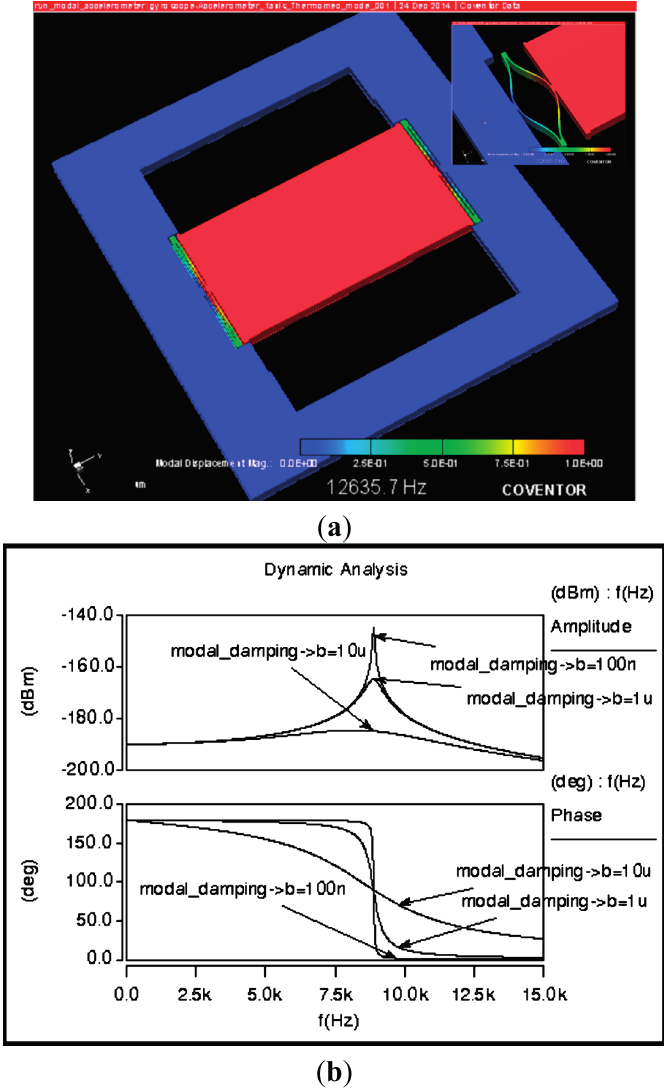
Figure 3. Device modeling results. ( a ) FEM modeling; ( b ) Lumped